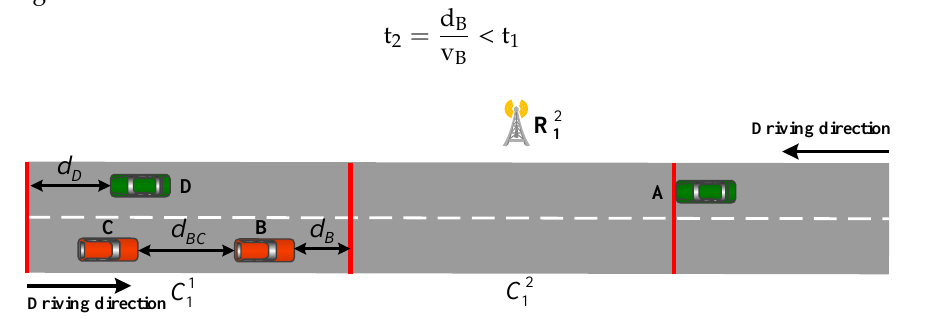
Figure 3. Car B is running in the opposite direction to car A in C 1